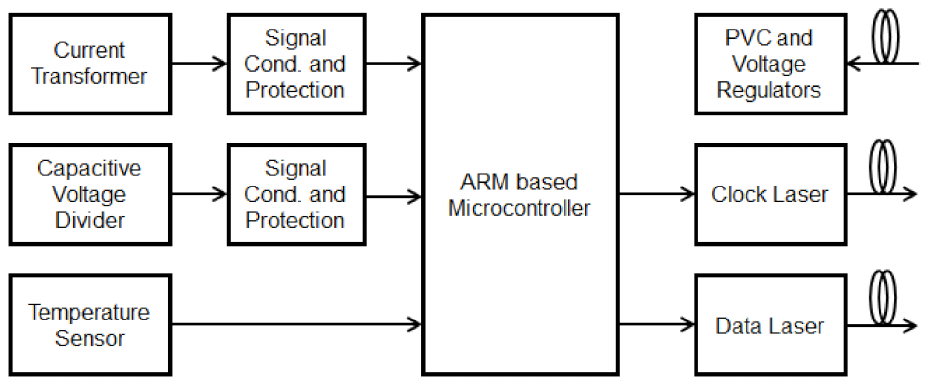
Figure 3. Block diagram of the sensor